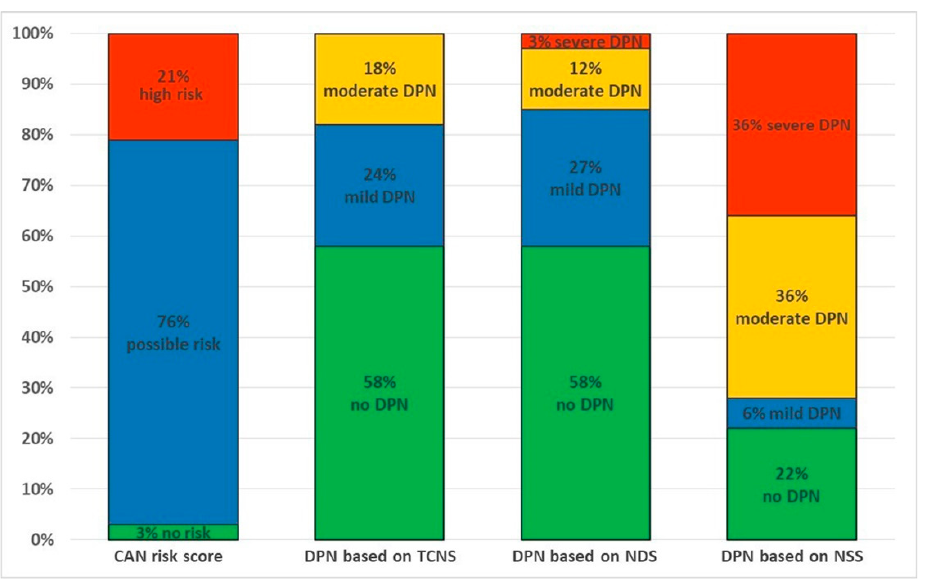
Figure 2. CAN risk score estimated by SUDOSCAN and DPN based on TCNS, NDS and NSS. Ab- breviations: CAN—cardiac autonomic neuropathy, DPN—diabetic peripheral neuropathy, TCNS—Toronto Clinical Neuropathy Score, NDS—Neuropathy Disability Score, NSS—Neuropathy Symptom Score.